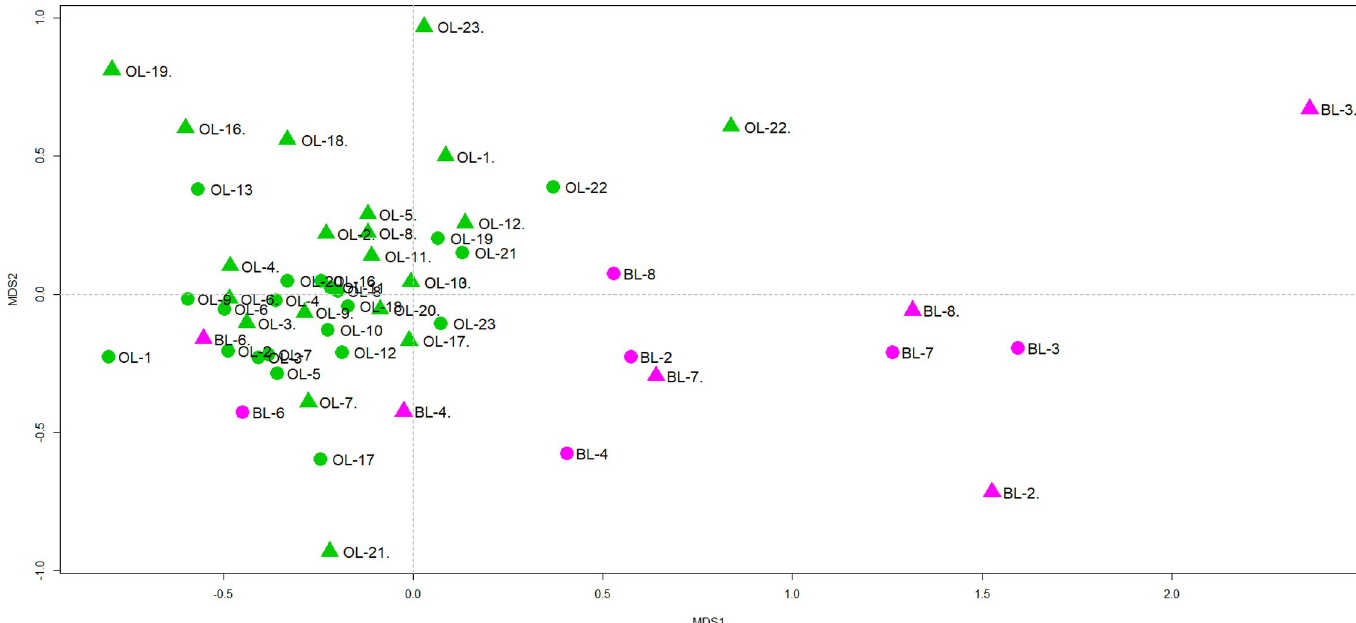
Fig 5. NMDS ordination for the fish community evaluated by multiple capture methods (TM, green color) and eDNA metabarcoding (MB, pink color).